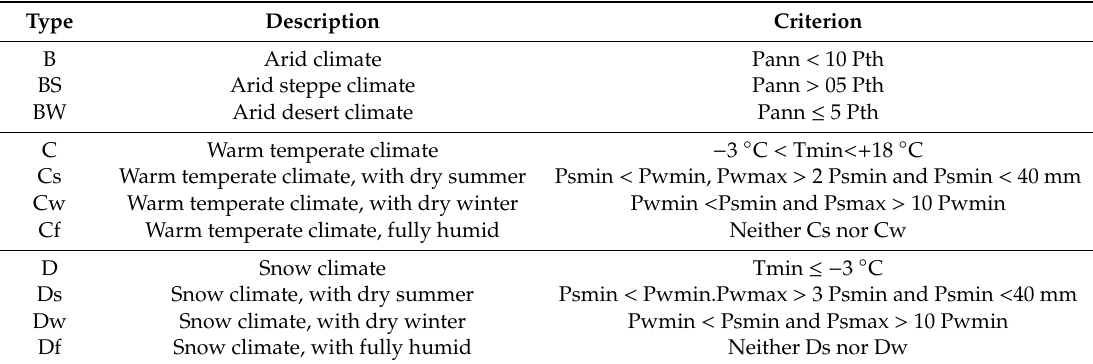
Table 2. Climate Classification Scheme of the Study